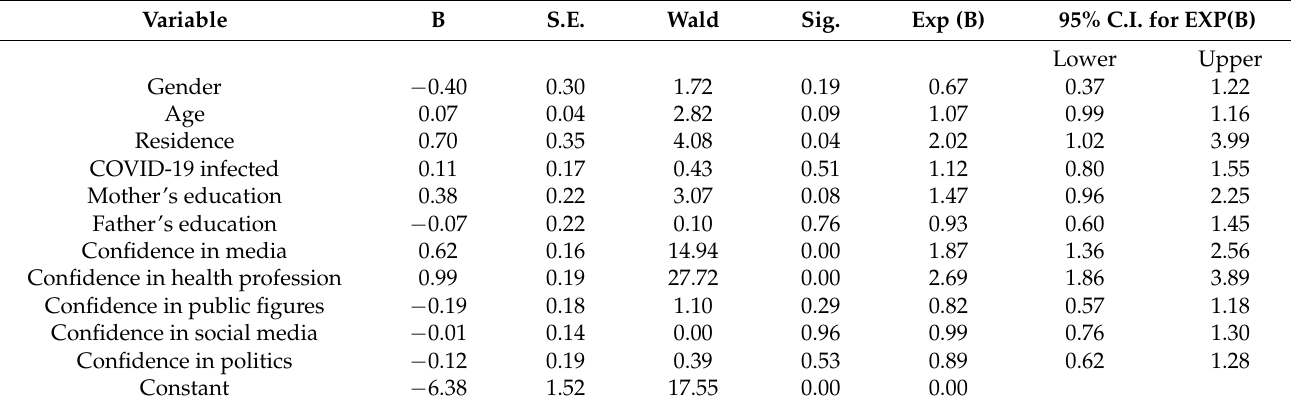
Table 5. Logistic regression